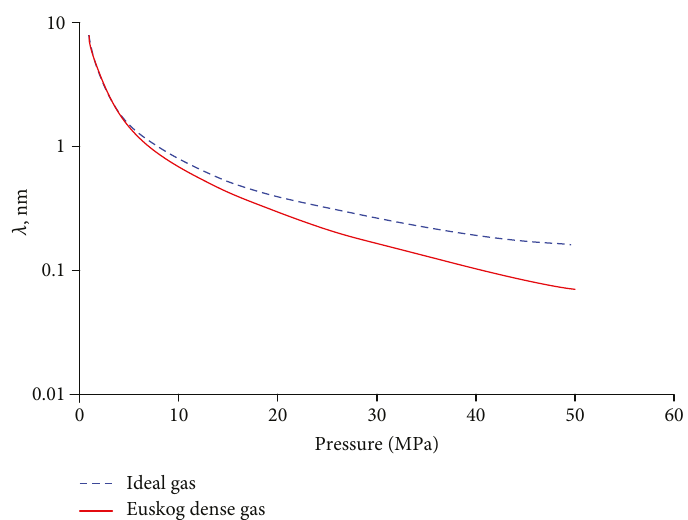
Figure 4: The e ff ect of dense gas on the mean free path of gas molecules ( T = 360K